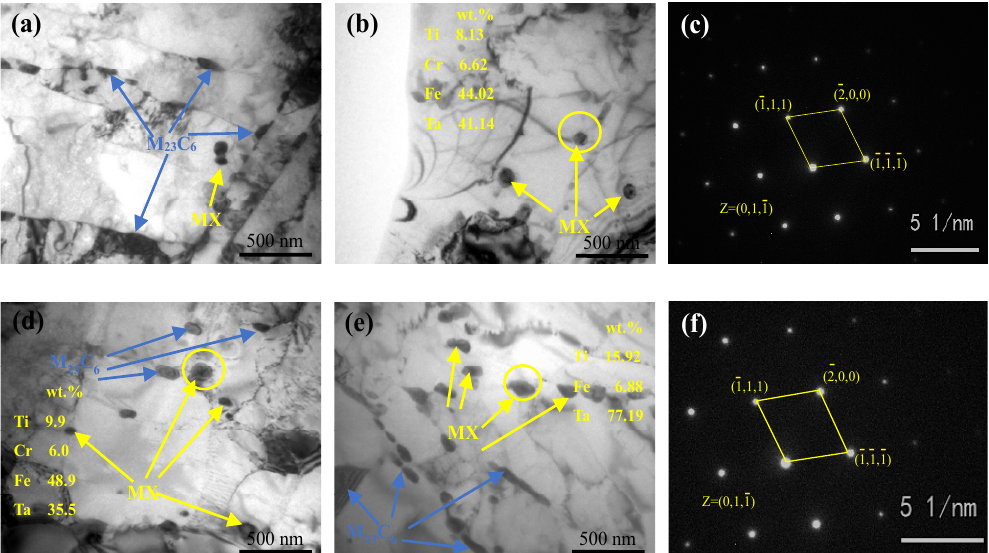
Figure 8. Precipitates of the tempered RAFM steels: ( a ) C1 and ( b ) C2; ( c ) corresponding fast Fourier transform (FFT) image of the MX carbides in C2, ( d ) C3, and ( e ) C4; and ( f ) corresponding FFT image of the MX carbides in C4.